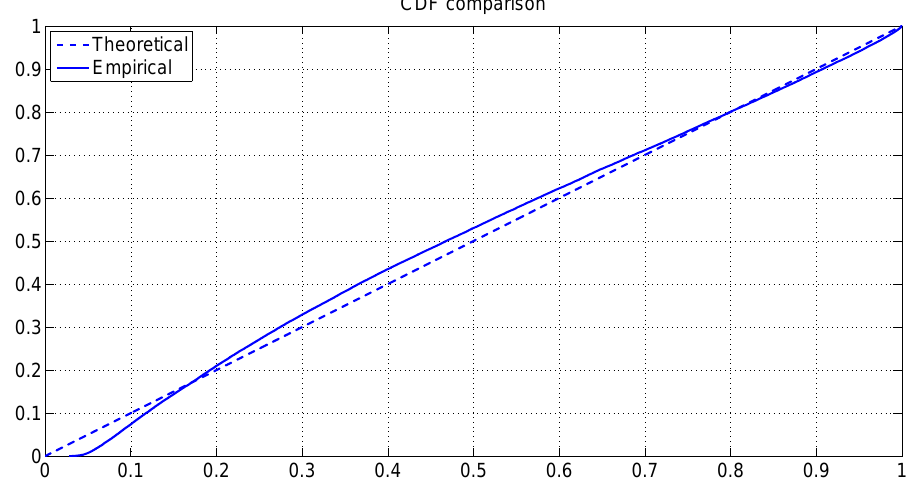
Figure 12. Comparison between the empirical CDF of the PITs and the theoretical CDF of a uniform distribution over the interval (0,1) based on the TSCD-W model to the Boeing transaction